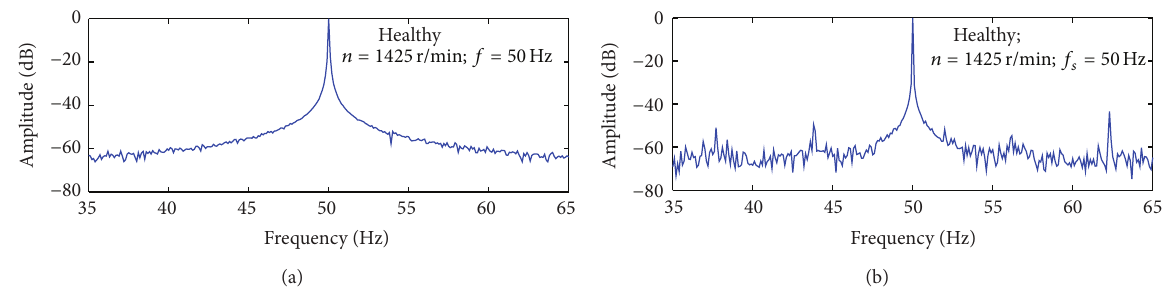
Figure7:Powerspectrumofthestatorcurrentaroundthefundamentalcomponentfor(a)main-fedand(b)inverter-fedhealthysquirrel-cage motor.